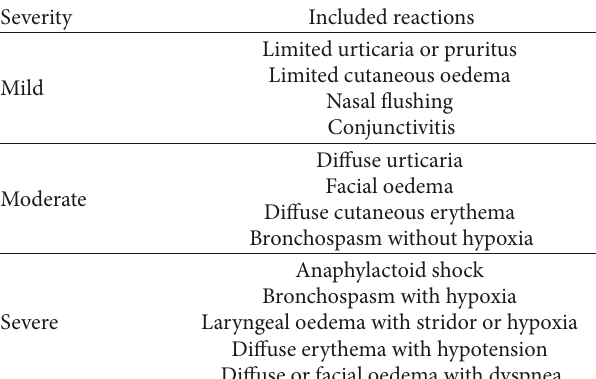
Table 1: Definition of CM adverse reaction